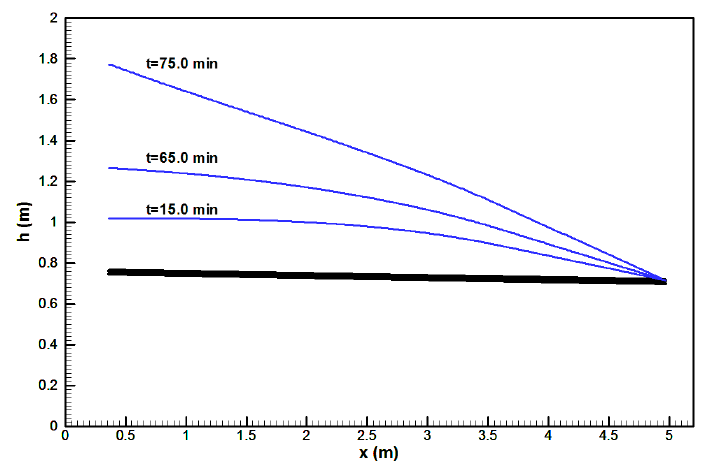
Figure 12. Conduit C1 (black lines) and the hydraulic head h (m) (blue lines) at different time steps.